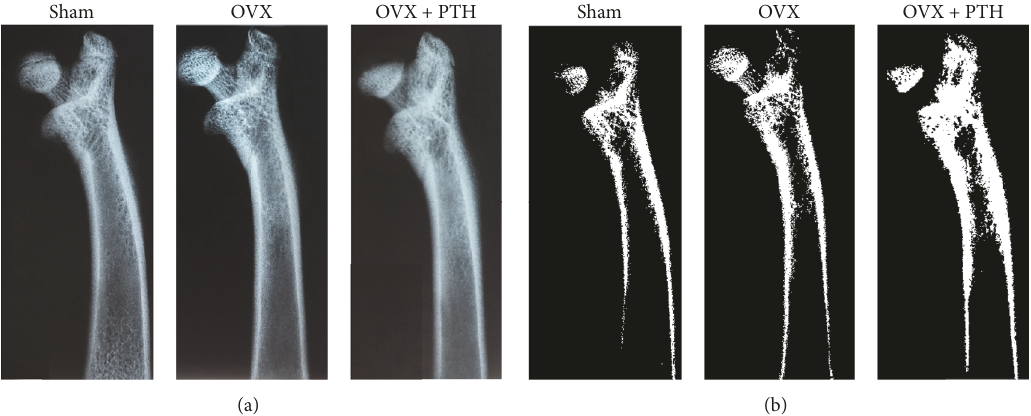
Figure 5: Prevention experiment reference measurements: example of microradiography of Sham, OVX, and OVX + PTH, treated with PTH at 6 weeks after operation. (a) Representative radiographs of femurs bones. (b) Radiographs following threshold analysis. PTH treatment increased the trabecular bone when compared with the Sham and the OVX controls. Slides were conducted with FAXITRON (a cabinet X-ray system, Hewlett-Packard).